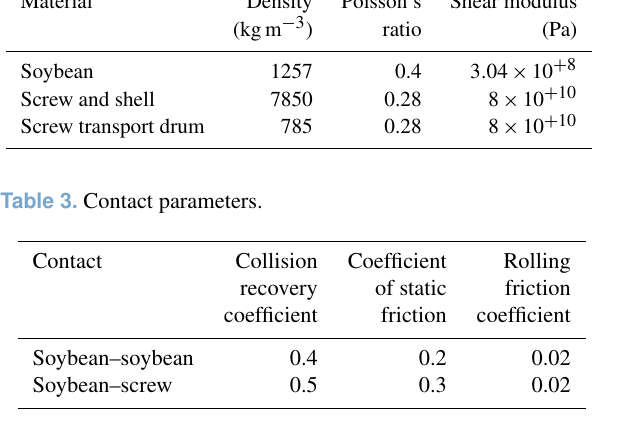
Table 2. Material parameters. Material